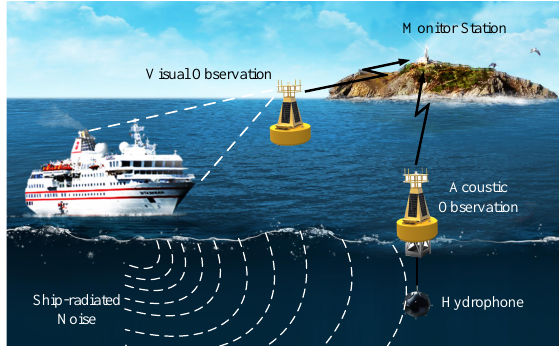
Figure 1. Application scenario of the multimodal-deep learning (DL) methods for ship-radiated noise